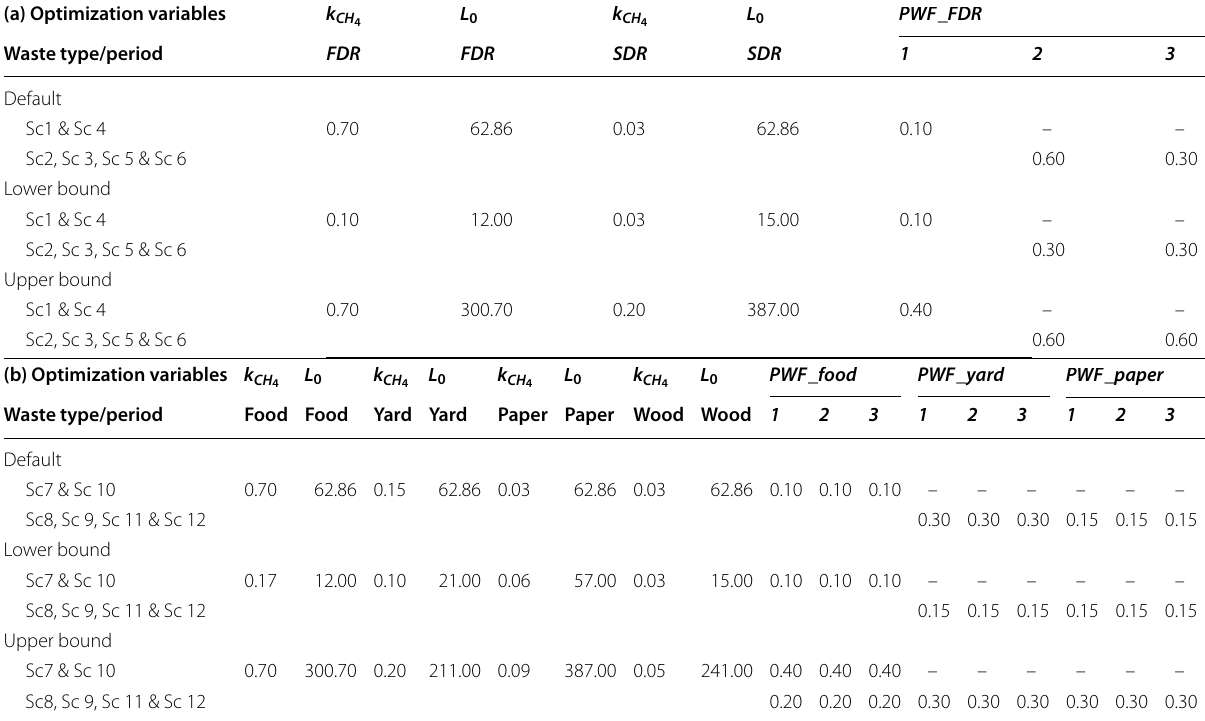
Table 3 Lower bound and upper bound of k CH 4 ( y − 1 ) and L 0 ( m 3 CH modeling, (a) FDR and SDR, (b) food, yard, paper, and